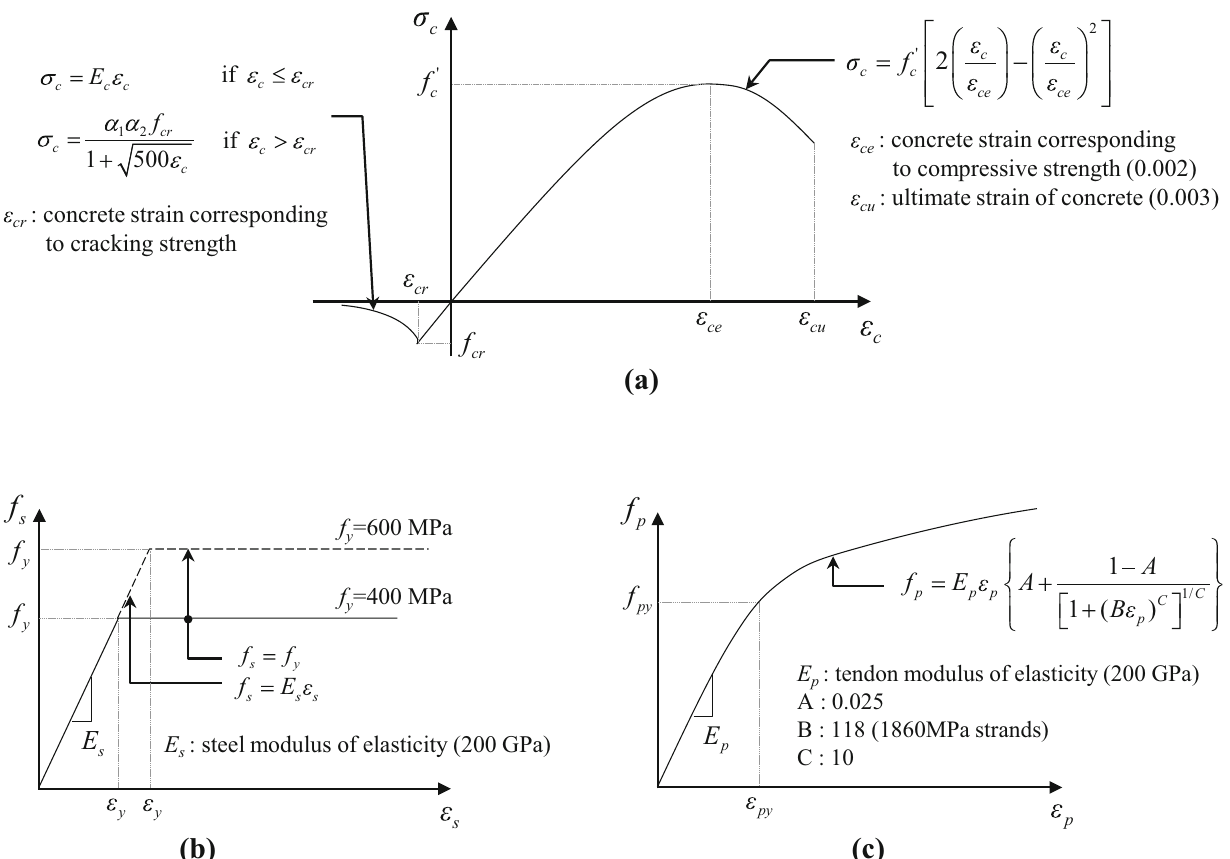
Fig. 4 Flexural behavior analysis. a Stress–strain curve of concrete, b Stress–strain curve of reinforcing steel, and c Stress–strain curve of